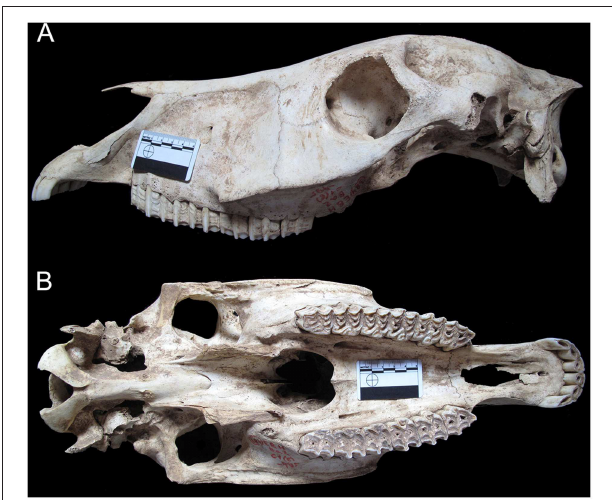
FIGURE 11 | Skull of Equus hydruntinus from the site Emine-Bair-Khosar, Crimea; catalog no. Ba2 384 (photo E. van Asperen; scale in cm; reprinted from van Asperen et al., 2012 © Palaeontological Association February 2012). (A) Lateral view; (B) Occlusal view.